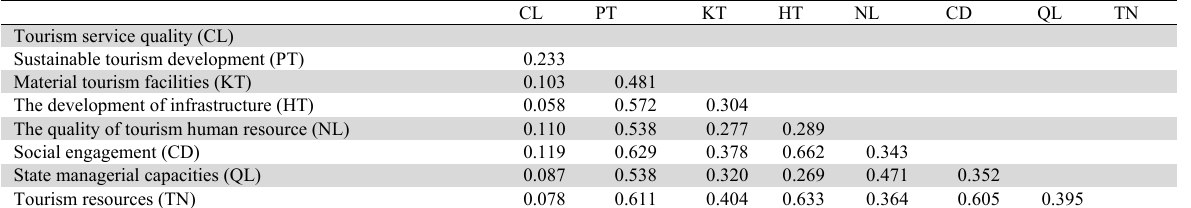
The results of analyzing the discriminant validity (HTMT-Heterotrait Monotraite Ratio)